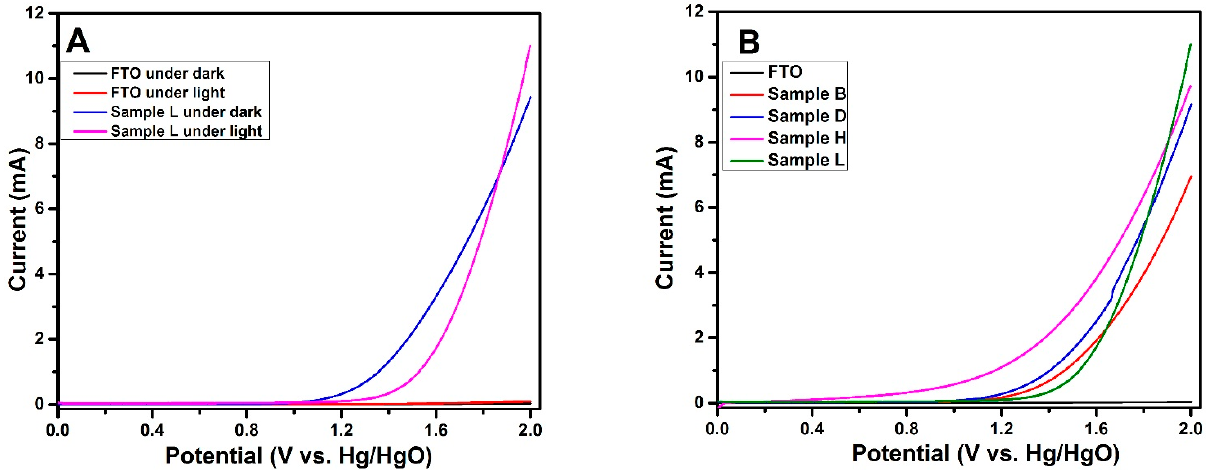
Figure 9. ( A ) IV curves of FTO and Sample L under darkness and illumination; ( B ) Phototriggered IV curves for FTO, Sample B, Sample D, Sample H, and Sample L.